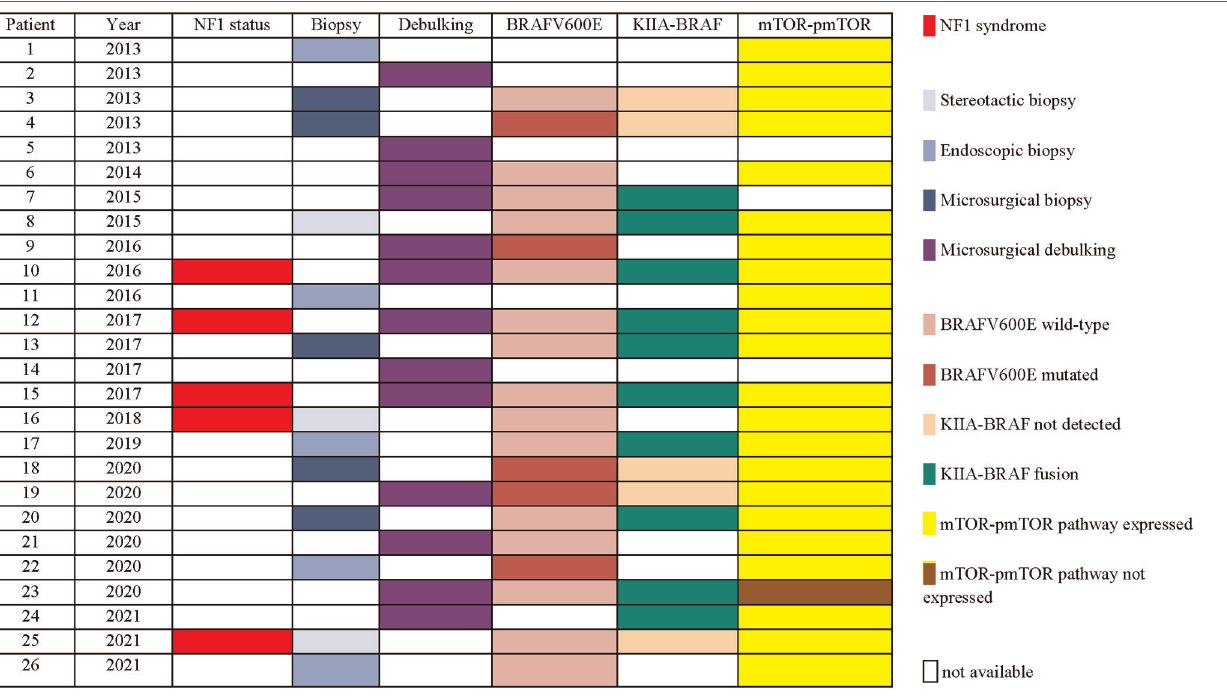
TABLE 2 | Surgical treatment and molecular fi ndings.